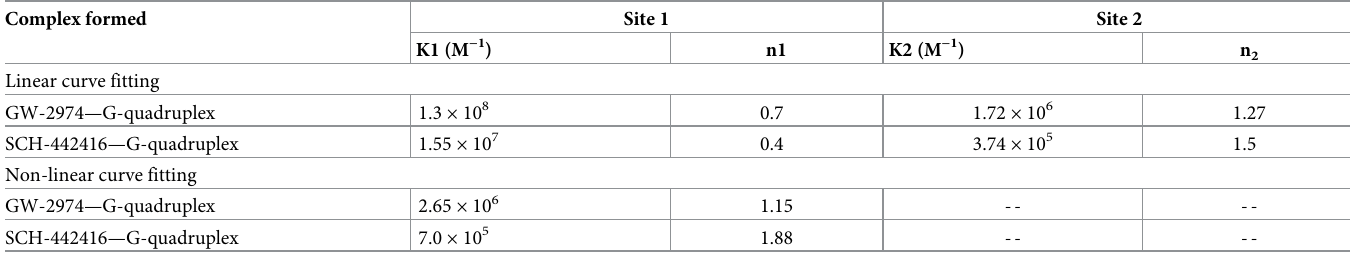
Table 1. Binding constants (K) and number of binding sites (n) of GW-2974 and SCH-442416 per a G-quadruplex DNA